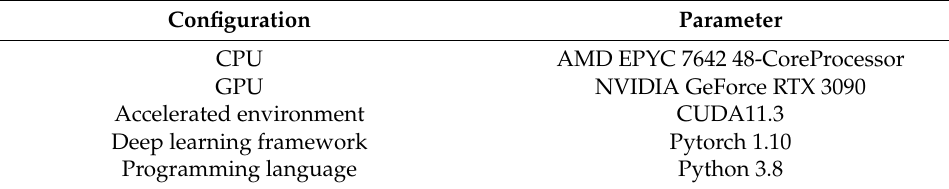
Table 1. Experimental environment. Configuration Parameter CPU GPU Accelerated environment Deep learning